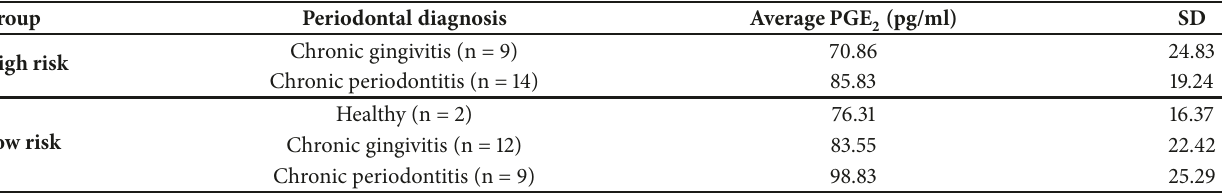
Table 3: PGE 2 levels by risk of preterm delivery and periodontal diagnosis.